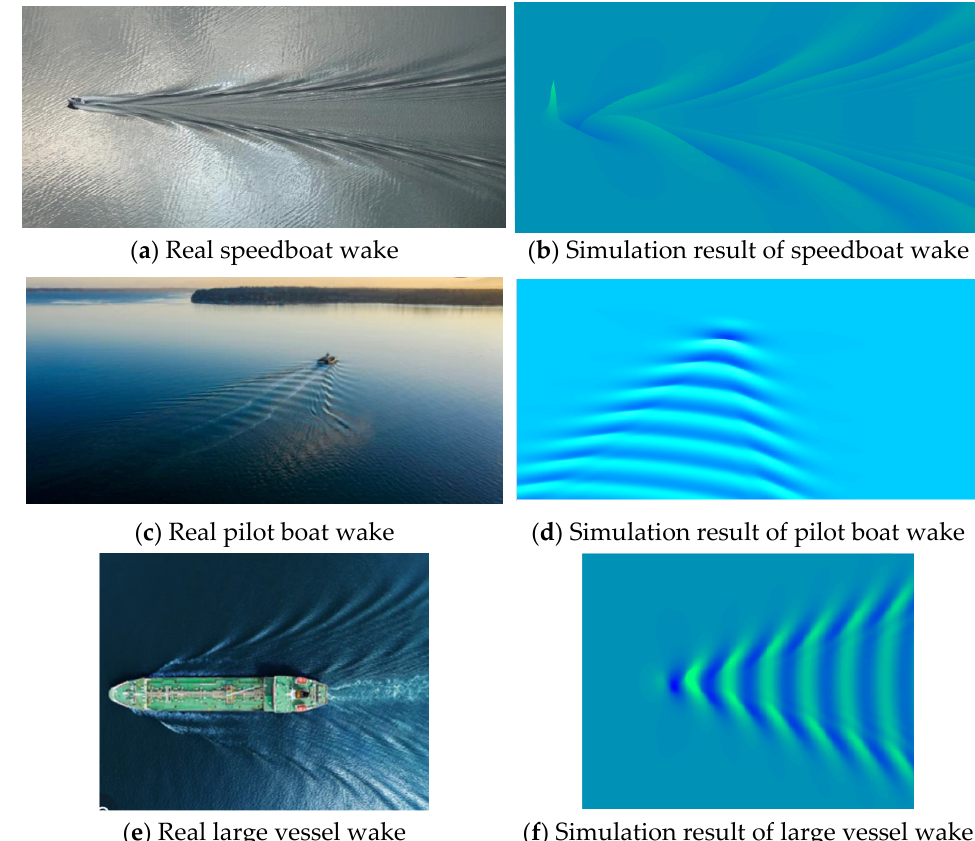
Figure 5. Comparisons between the three types of real ship waves and the corresponding simulation results. The pictures of real ship wave patterns come from internet: ( a ) speedboat wake, from https://commons.wikimedia.org/wiki/File:Fjordn_surface_wave_boat.jpg accessed on 5 January 2022; ( c ) pilot boat wake, from https://www.shutterstock.com/zh/image-photo/small-ferry-boat-route-mainland-during-1706813791 accessed on 1 May 2022; ( e ) large ves- sel wake, from https://www.istockphoto.com/photo/aerial-top-view-oil-ship-tanker-full-speed- transportation-oil-from-refinery-on-the-gm1159334567-316959177 accessed on 5 January